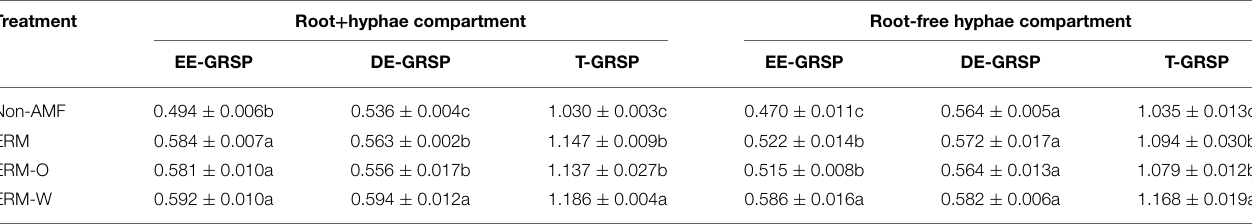
TABLE 2 | Concentrations of glomalin-related soil protein (GRSP, mg/g DW) fractions in root + hyphae and hyphae compartment of trifoliate orange inoculated with or without Funneliformis mosseae and grown in 37 µ m nylon-mesh separated root/hyphae compartments. Treatment